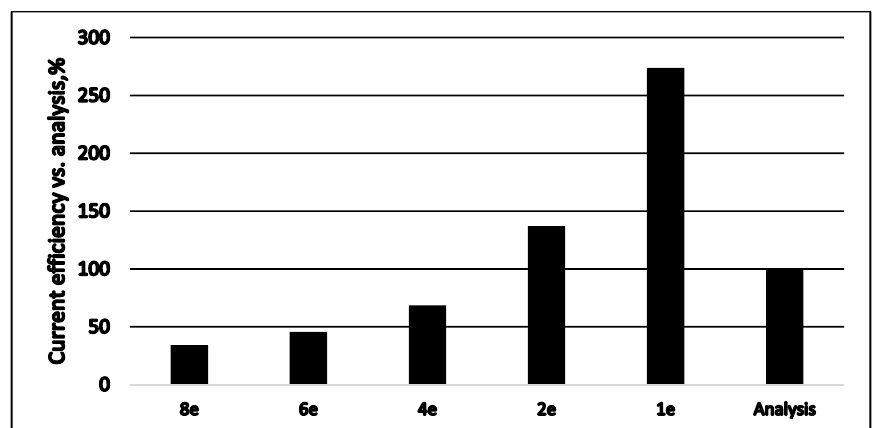
Figure 9. Comparison of current efficiencies calculated for a different number of exchanged electrons to the analytical data on sulfide depletion (as 100%). Data taken from Figure 7b.